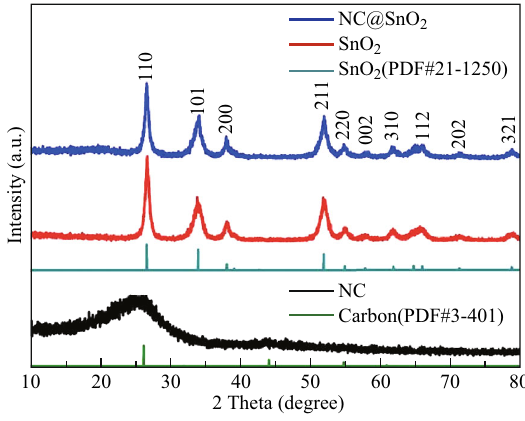
Fig. 2 a , b SEM images of SnO 2 . c , d SEM images and e , f TEM images of NC@SnO